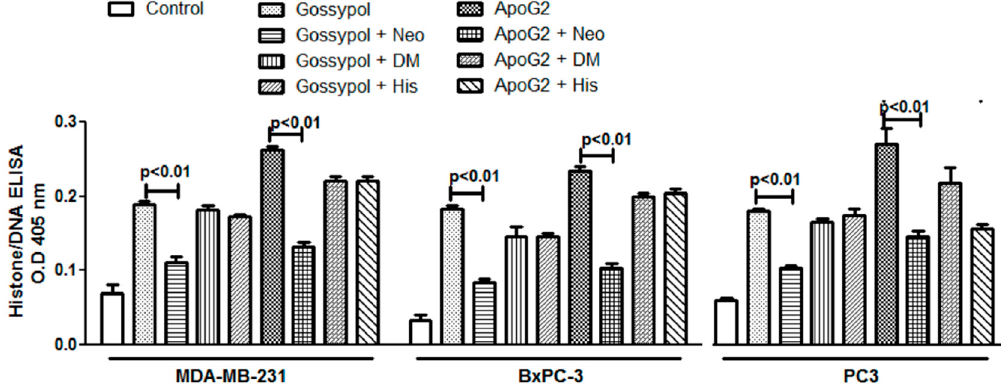
Figure 3. Cancer cell lines were incubated with 50 μ M redox-metal-specific chelators, and treated with 5 μ M gossypol/ApoG2 and further processed as described in the Materials and Methods. Neo: neocuproine; DM: desferrioxamine mesylate; His: Histidine. All results presented are mean (±SEM) of three independent experiments.